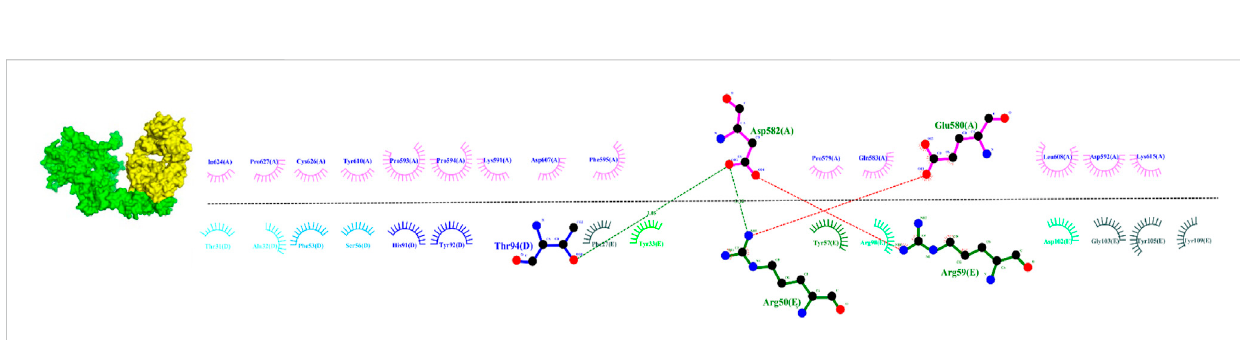
the interaction between trastuzumab (yellow, chain E) and ErbB2 (green, chain A) extracted from 6OGE PDB